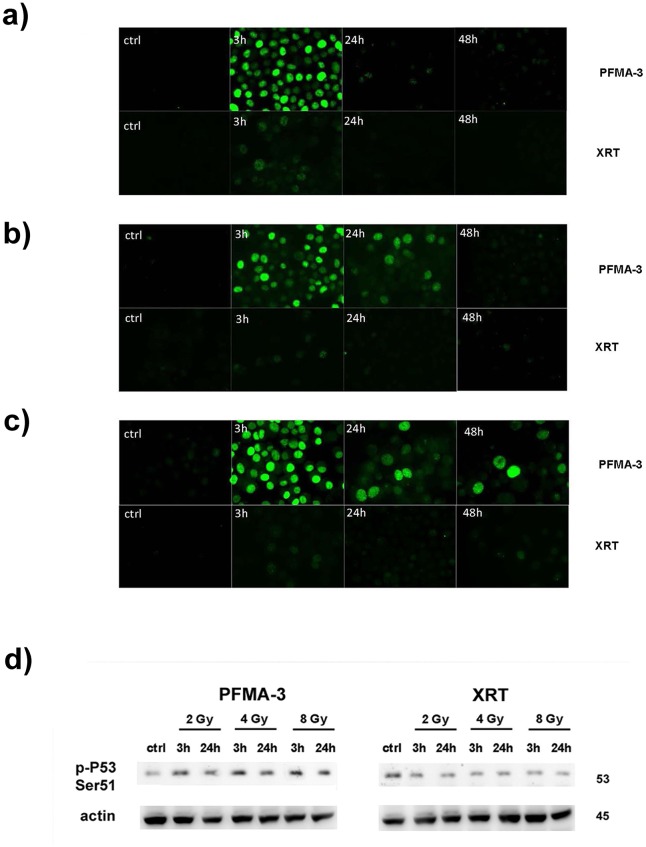
PFMA-3 causes a DNA-DSB more severe with respect to XRT in SK-Mel28.Induction of DSB was assessed through detection of phosphorylation of H2A.X at Ser139 (green) by immunofluorescence and microscopy analysis. a) DSB after 2 Gy treatment. b) DSB after 4 Gy treatment. c) DSB after 8 Gy treatment. ctrl, control cells. d) Western blot analysis documenting phospho-p53 (Ser51) levels modulation in PFMA-3 and XRT irradiated samples. Antibody to b-actin served as a loading control. ctrl, control cells.